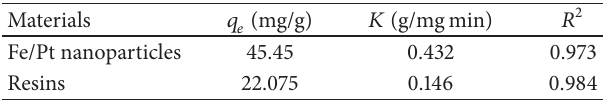
Table 2: Pseudosecond-order kinetic plots for the adsorption of nitrate ions on